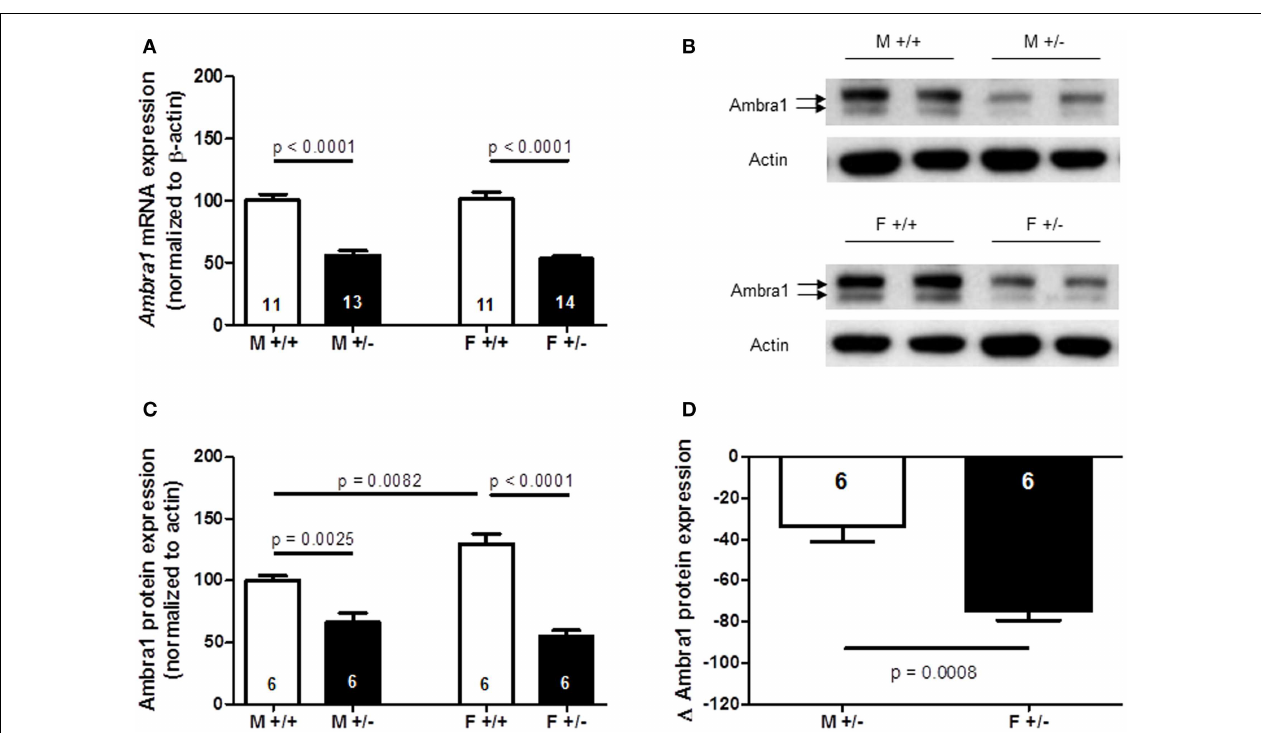
significantly higher relative reduction (delta) from the respective wildtype control ( Ambra1 + / + ) of Ambra1 protein in cortex of female as compared to male Ambra1 + / − mice. M, male; F, female; Mean ± SEM presented; respective sample sizes are indicated in the